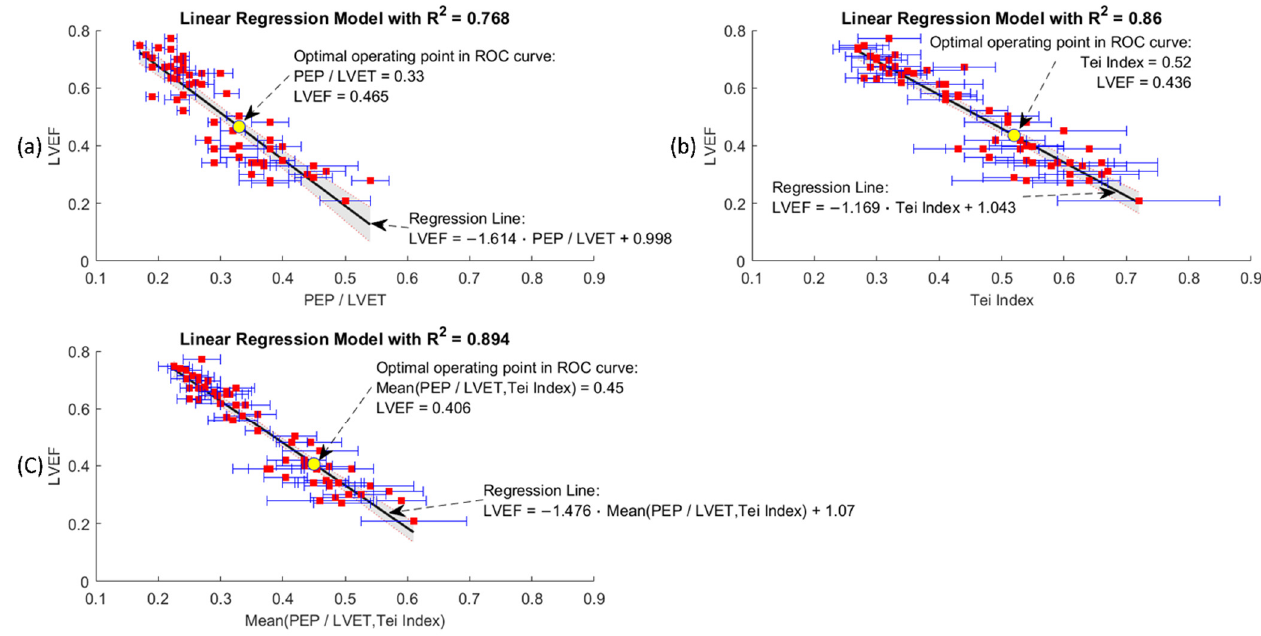
Figure 9. Linear regression models of clinical LVEF assessment versus: ( a ) PEP/LVET ration; ( b ) Tei index; ( c ) mean of PEP/LVET and Tei index. Each graph is annotated with mean (red squares) and standard deviation (blue error bars) of the variable from subjects, the 95% confidence interval of the regression line (shaded area), the coefficient of determination (R2) and the optimal operating point determined in the ROC curve analysis (yellow point).